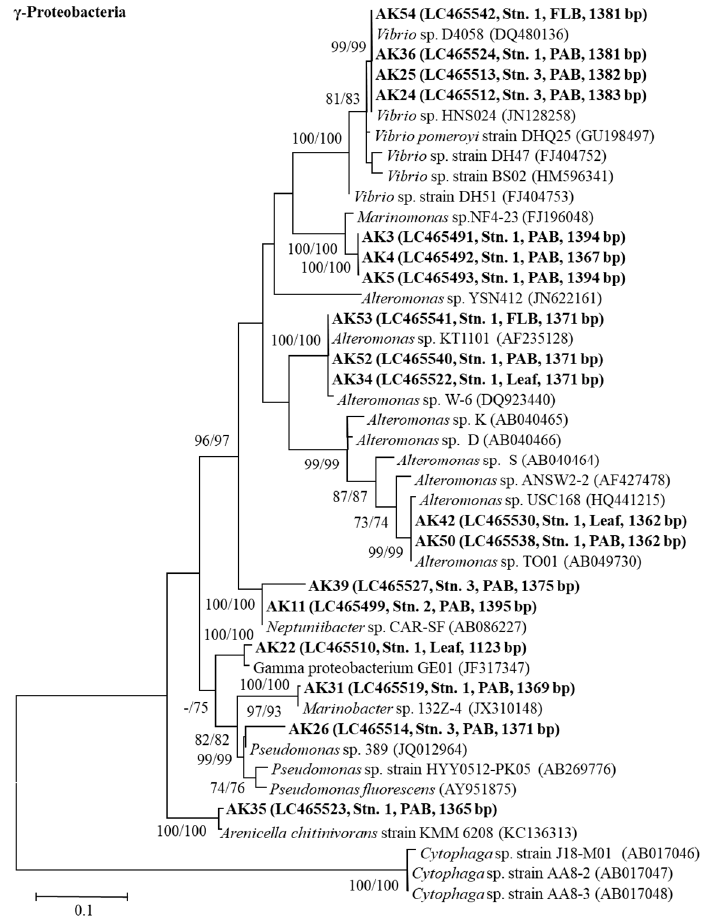
Figure 11. Phylogenetic tree for γ -proteobacteria on the basis of 16S rRNA gene sequences (~1300 bp). Figure 12. Phylogenetic tree for γ - proteobacteria on the basis of 16S rRNA gene sequences (~1300 See the legend of Figure 14 for the explanation of the bp). See the legend of Figure 11 for the explanation of the tree.